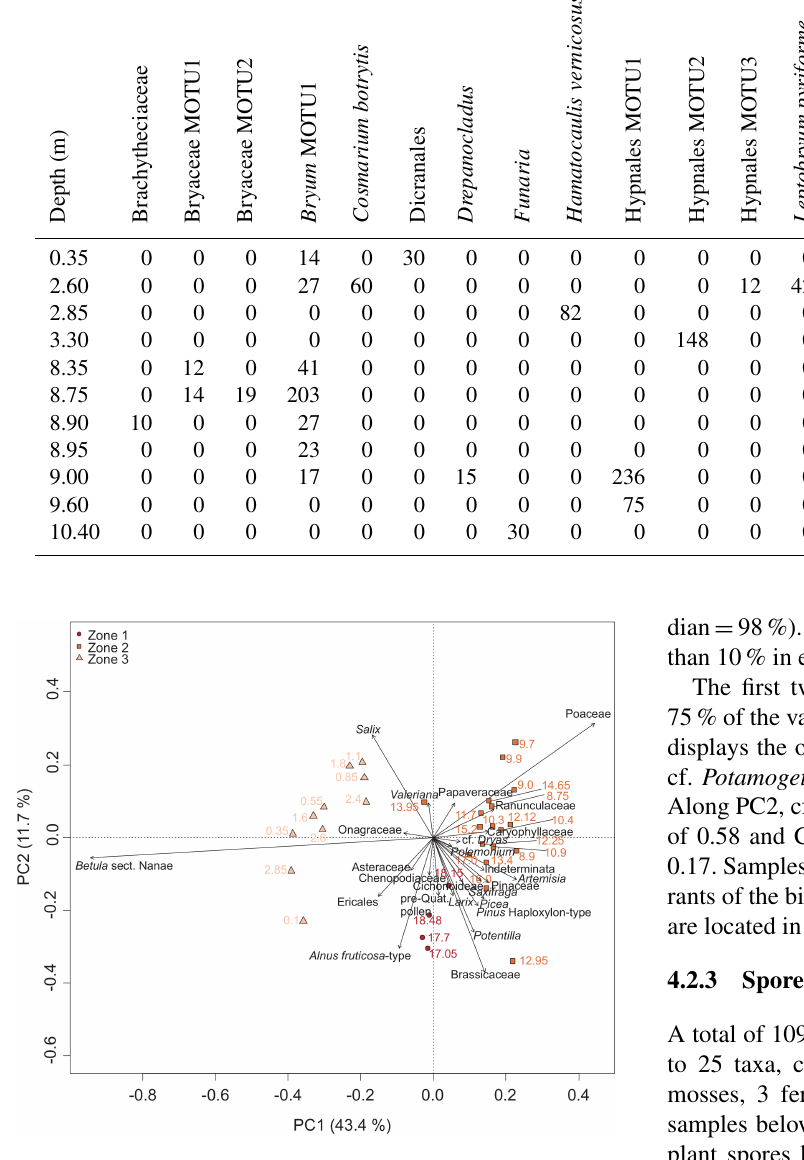
Figure 7. PCA biplot of terrestrial taxa from pollen analysis, show- ing a subset of 23 taxa, indeterminate and pre-Quaternary pollen, which explained most of the variance in the dataset. Sample depths (m) are coloured according to their corresponding zone. Explained variances of the two principal components (PC) are shown in brack-